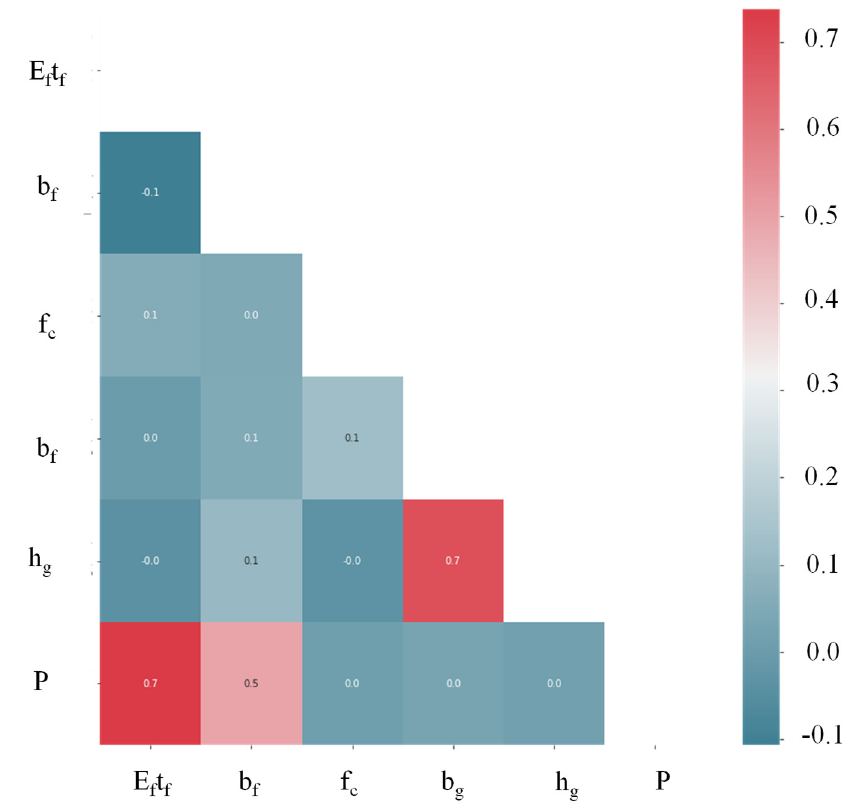
Figure 2. Pearson’s linear correlation for the data used in the model’s development.